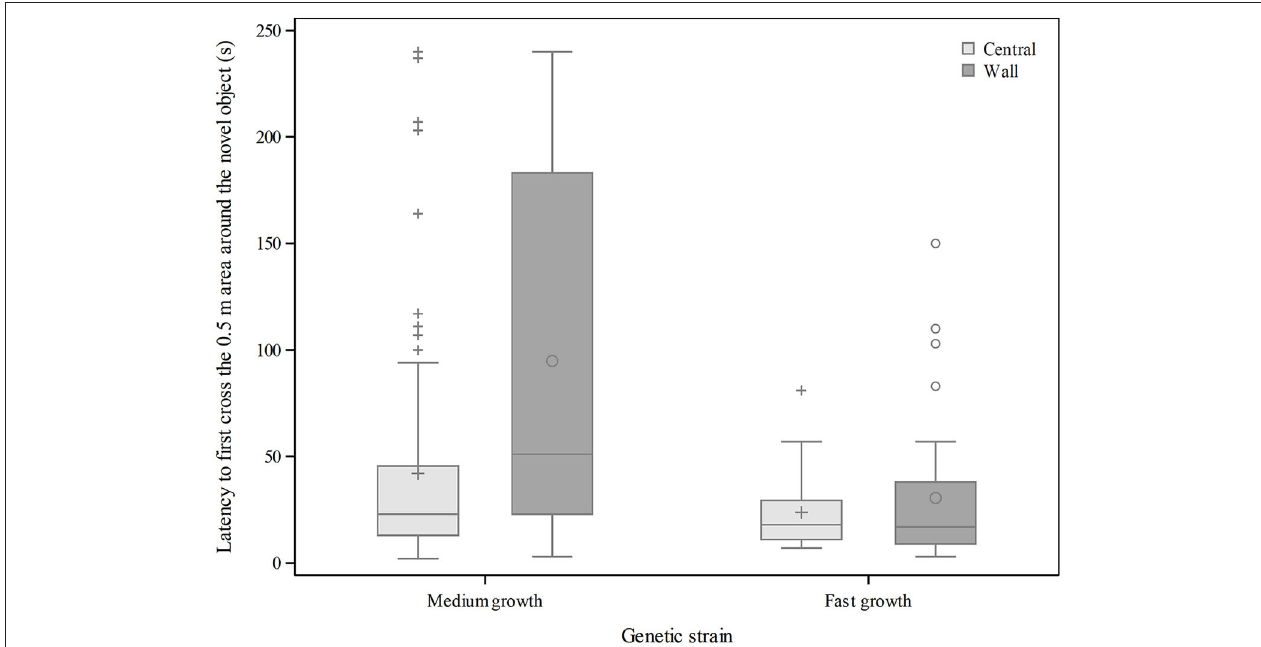
FIGURE 4 | Interaction between the genetic strain and the assessment house location on the latency to first cross the 0.5m area around the novel object. Boxes show interquartile ranges, and whiskers represent minimum and maximum values. Symbols ( + , ◦ ) inside boxes indicate the mean value, while symbols ( + , ◦ ) outside whiskers represent